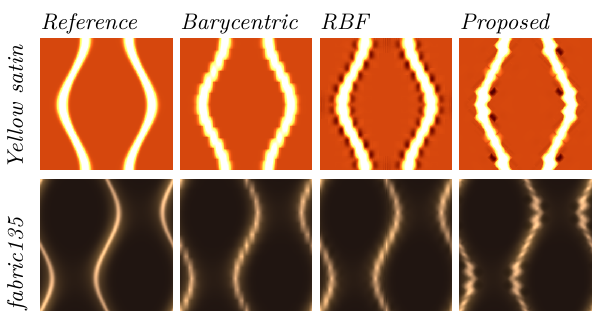
Fig. 16 Example of a limitation of the proposed interpolation method, when highlights are not perpendicular to the axial or diagonal slices ( θ i = 30 ◦ , θ v = 75 ◦ ).